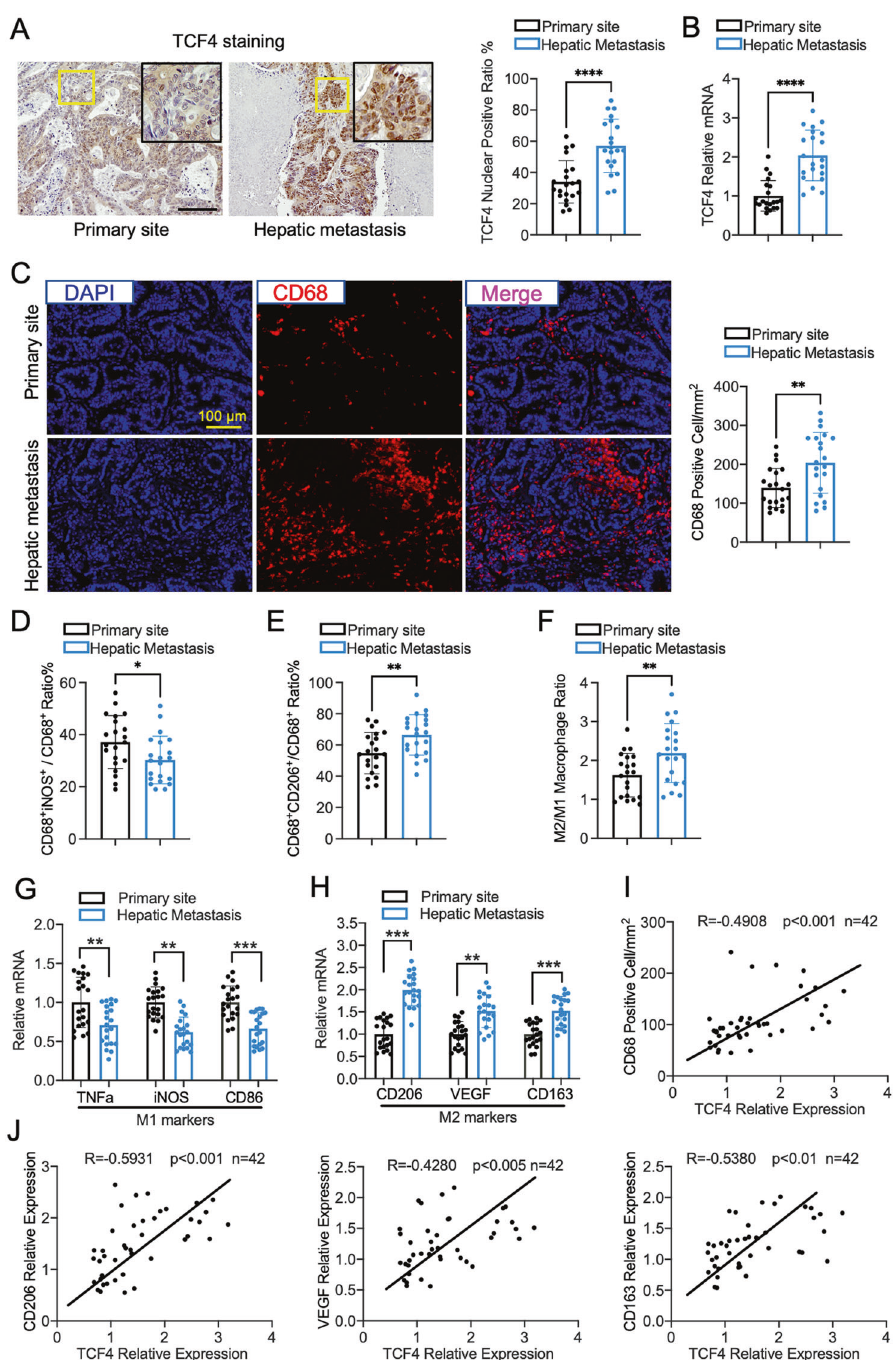
Fig. 1 TCF4 expression is elevated in colorectal cancer hepatic metastasis compared with the primary site and is correlated with tumor- associated macrophage recruitment in the tumor area. A Representative images and quanti fi cation of TCF4 immunohistochemistry staining in human primary colorectal cancer sample and hepatic metastatic sample. n = 21 each group; Scale bar, 100 μ m; fi ve fi elds were counted per sample. B TCF4 mRNA expression in human samples. C Representative immuno fl uorescence staining and quanti fi cation of CD68 expression in human colorectal cancer tissue collected from the primary site and hepatic metastasis. Scale bar, 100 μ m; fi ve fi elds were counted per sample. D Quanti fi cation of M1 macrophage(CD68 + iNOS + staining cells)/total TAMs(CD68 + staining cells) ratio in human colorectal cancer primary site and hepatic metastases. E Quanti fi cation of M2 macrophage(CD68 + CD206 + staining cells)/total TAMs(CD68 + staining cells) ratio in human colorectal cancer primary site and hepatic metastases. F M2/M1 macrophage ratio in human samples. G Relative mRNA expression of TNFa, iNOS, CD86 in human colorectal cancer samples. H Quantitative PCR results of CD206, VEGF, and CD163 expression in human colorectal cancer samples. I Pearson correlation coef fi cient and p-value between TCF4 mRNA expression and CD68 positive cells density in colorectal cancer samples. (Total n = 42; Primary site, n = 21; hepatic metastasis, n = 21). J Pearson correlation coef fi cient and p-value between TCF4 mRNA expression and CD206, VEGF, CD163 mRNA expression. (Total n = 42, Primary site, n = 21; hepatic metastasis, n = 21). Data are means ± SEM. * P < 0.05, ** P < 0.01, *** P < 0.005, **** P <